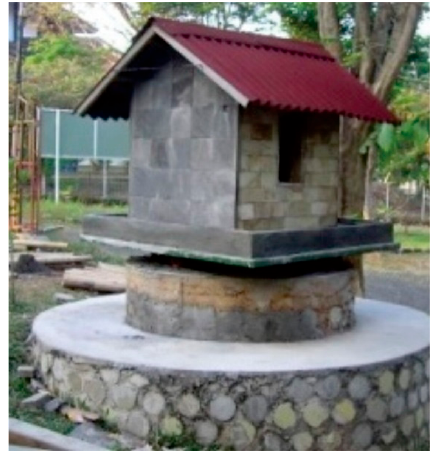
Figure 1. Miniature house as measurement object.